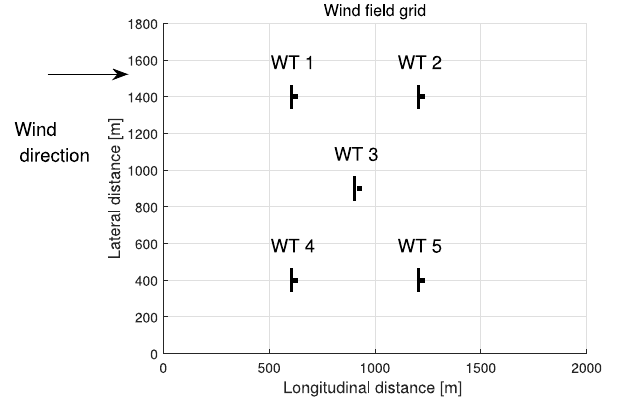
Figure 7. Layout of the proposed wind farm with five turbines of 5MW each.